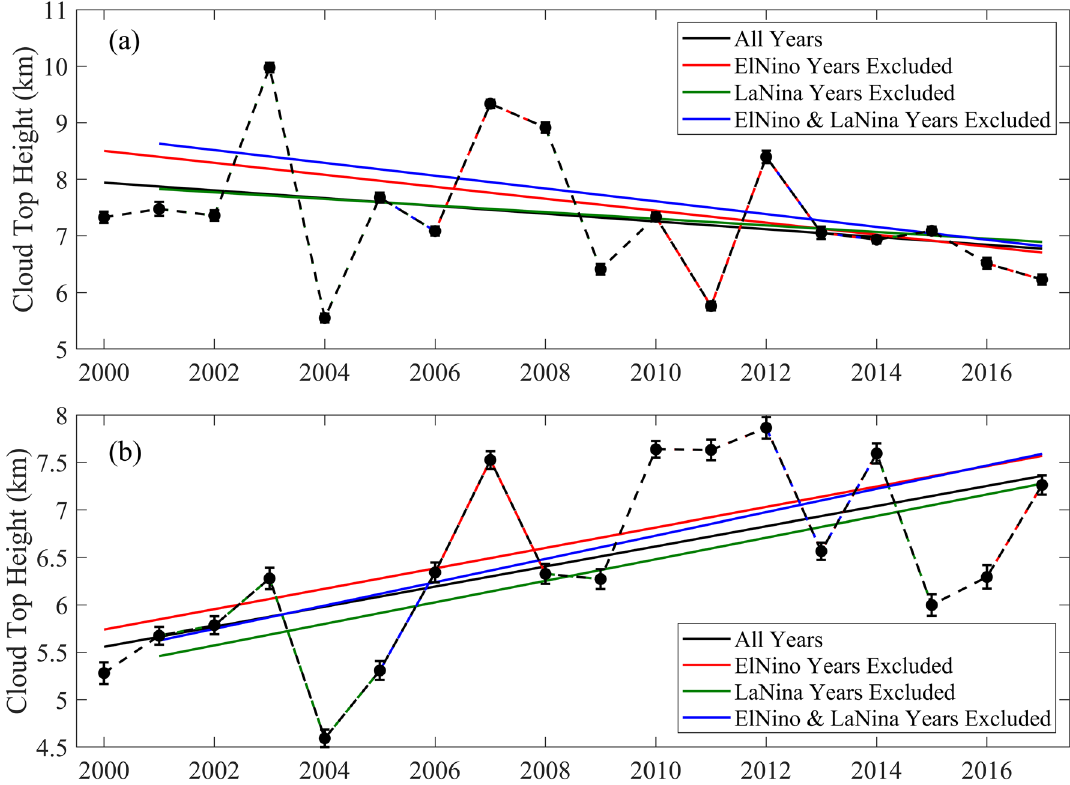
to 2017. Black curves show the inter-annual variations and trends of CTH by considering all the years during the selected period, whereas red, green and blue curves show the same by excluding El Niño years, La Niña years and both El Niño and La Niña years. While filled circles show annual mean values of CTH, vertical bars represent corresponding standard errors. Solid lines in the figures show the estimated linear trends, for the four cases mentioned